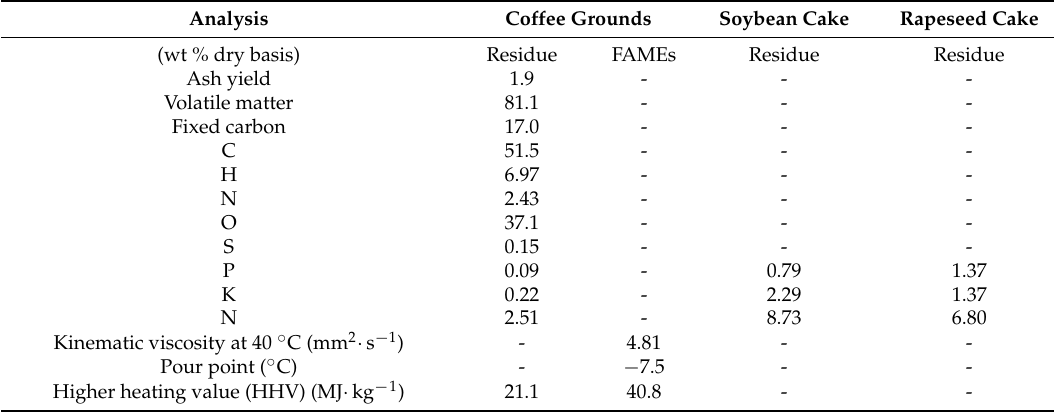
Figure 2. Gas chromatography analysis of the fatty-acid methyl esters (FAMEs) from IFWs. The presence of various methyl esters is shown in the inset table. Table 2. Properties of residues and FAMEs derived from IFWs.